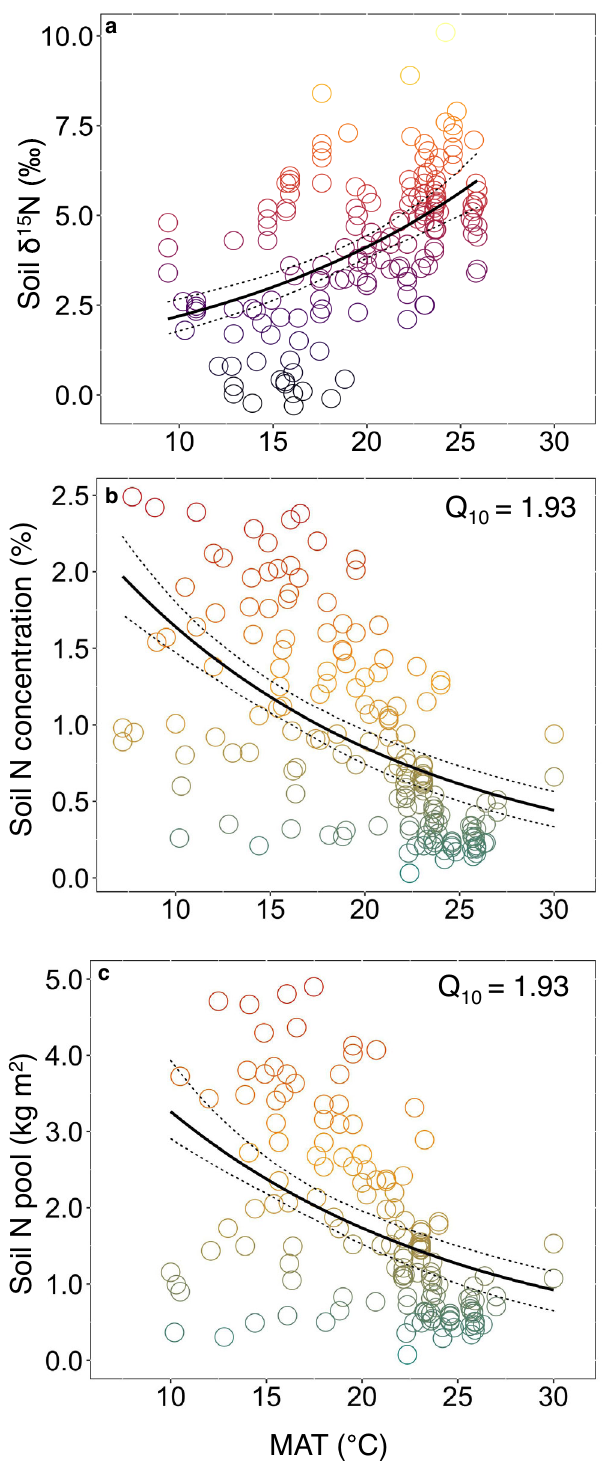
Fig. 3 | Temperature sensitivity of tropical montane forest N. Curves were fi t using nonlinear regression of δ 15 N ( a ), soil N concentrations ( b ) and N pools ( c ) against MAT across all elevational transects. Temperature sensitivities ( Q 10 ) were then determined for ( b ) and ( c ) using regression model results (Methods). Models were fi t using elevational transect data and additional lowland sites from a global tropical soil dataset 37 . ( a ) Lowland n =112, montane n =160, ( b ) lowland n =119, montane n =158( c ) lowland n =117,montane n =154. The color scalefollows Fig.